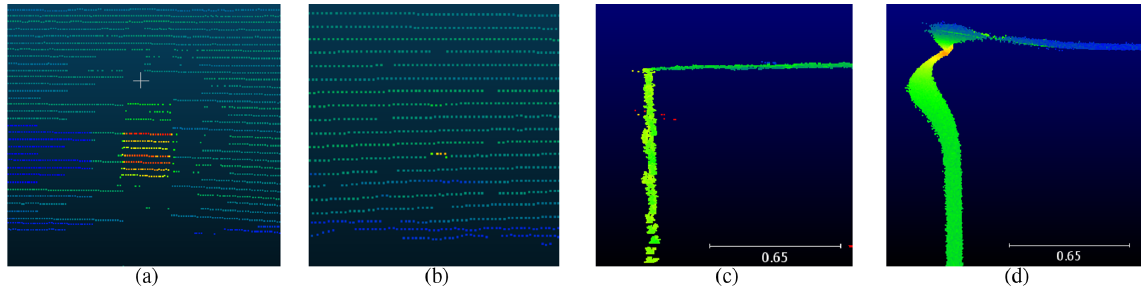
Figure 4. Artifacts observed in the accuracy tests: (a) and (b) areas without data resulting from the blooming filter in the OS1-64 data, (c) a part of the OS1-64 point cloud with a corner of the room, and (d) a part of the VZ-6000 point cloud with a corner of the room.